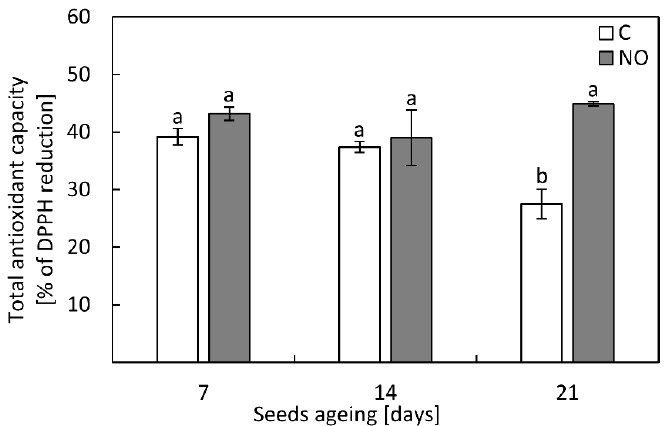
Figure 6. Total antioxidant capacity in the axes of apple embryos isolated from seeds subjected to accelerated ageing for 7, 14 and 21 days (C) or embryos isolated from aged seeds and treated with NO (NO). Values are average ±SD of 3 ‐ 4 independent repetitions. Different letters indicate significant differences confirmed by Tukey’s test ( p < 0.05).